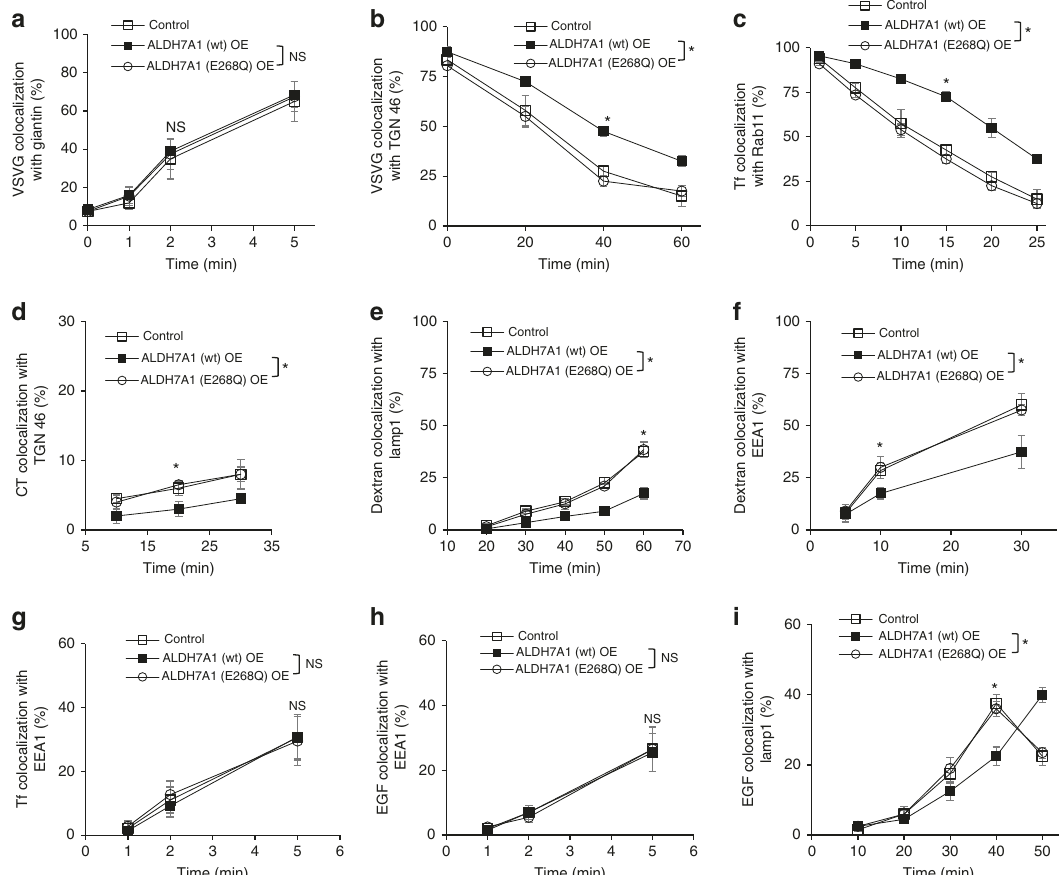
Fig. 3 ALDH7A1 overexpression inhibits intracellular pathways. Quantitative results are shown as mean with standard deviation; * p < 0.05, NS